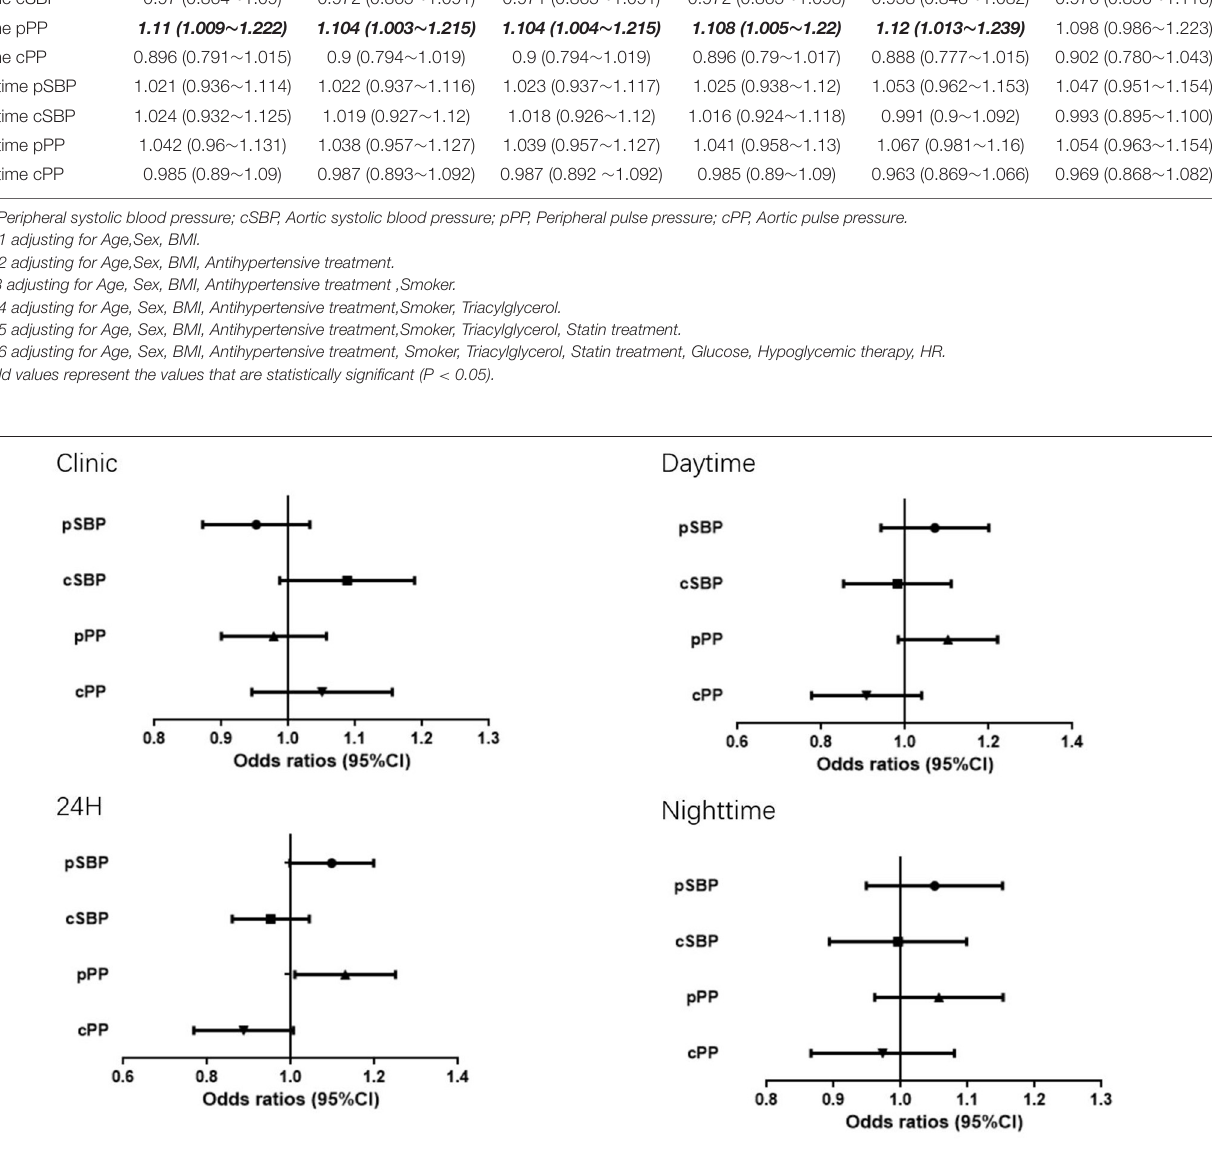
Frontiers in Cardiovascular Medicine |